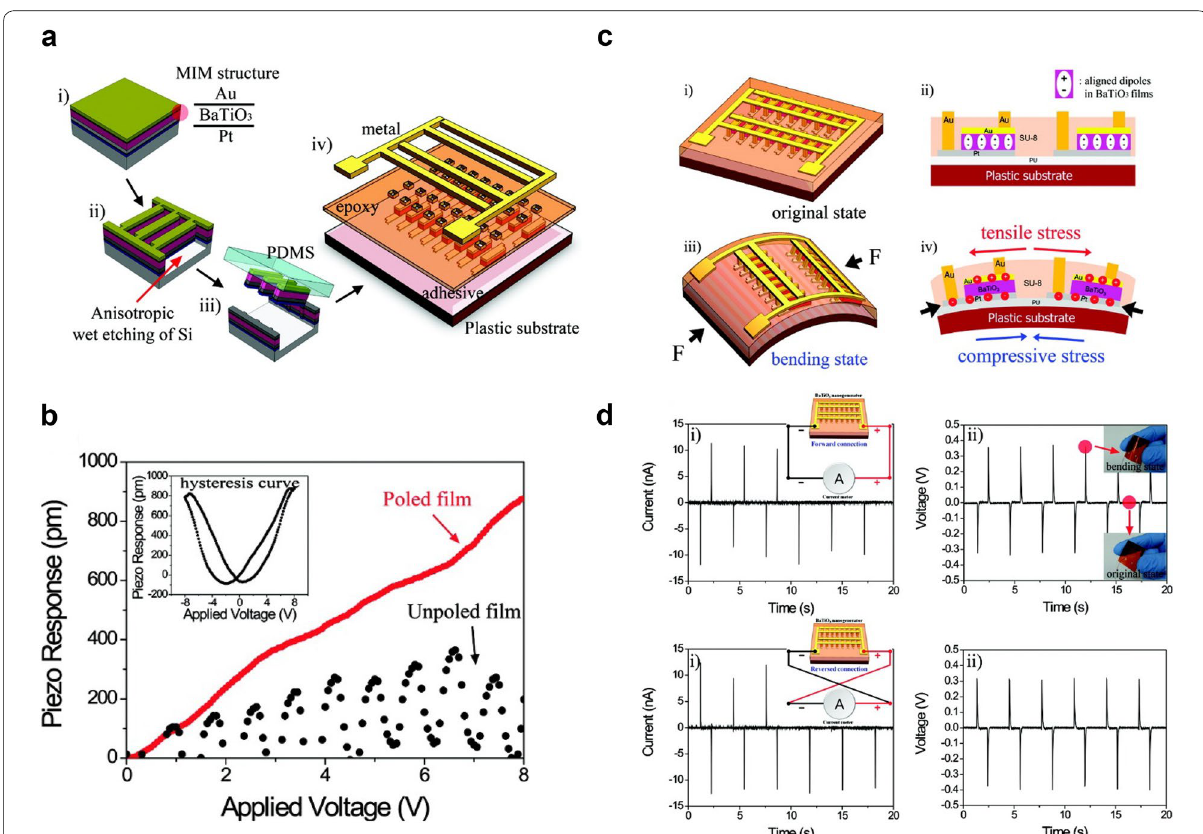
Fig. 2 a Fabrication process of MIM structure and schematic structure of PENG with BTO thin film. b PFM measurement of BTO thin film prior to and after poling. c Deformation of BTO thin film under mechanical stress and charge induction. d Output current and voltage of PENG with fore and reverse connection (Reproduced from [15] with copyright permission from 2010 American Chemical